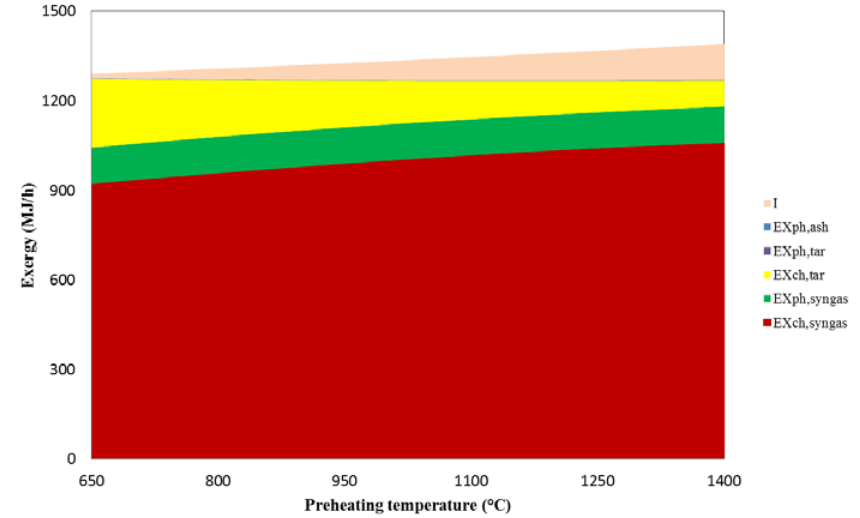
Figure 7. Exergy balance of the HTAG process as a function of preheating temperature for S/B = 1.